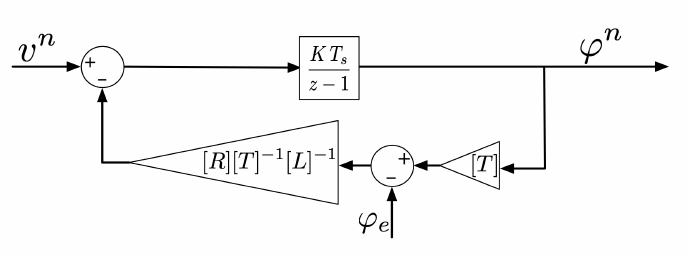
Figure 4. Discrete time model using built in integrator: SIMULINK-DSCR.